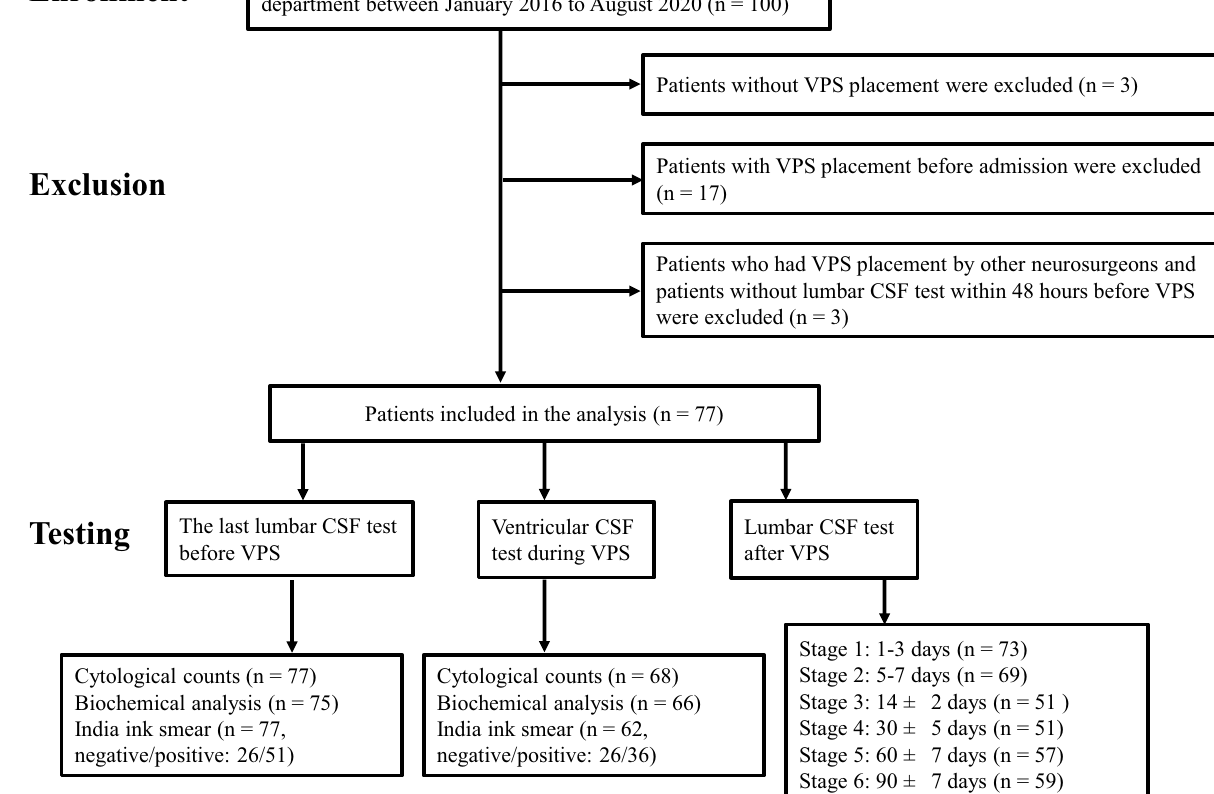
Figure 1. Research flow. A total of 100 patients with CM were admitted in neurosurgery department between January 2016 to August 2020. 23 patients were excluded. The number of patients who had CSF analysis at the indicated time was shown. The last lumbar CSF test before VPS was done within 48 h before